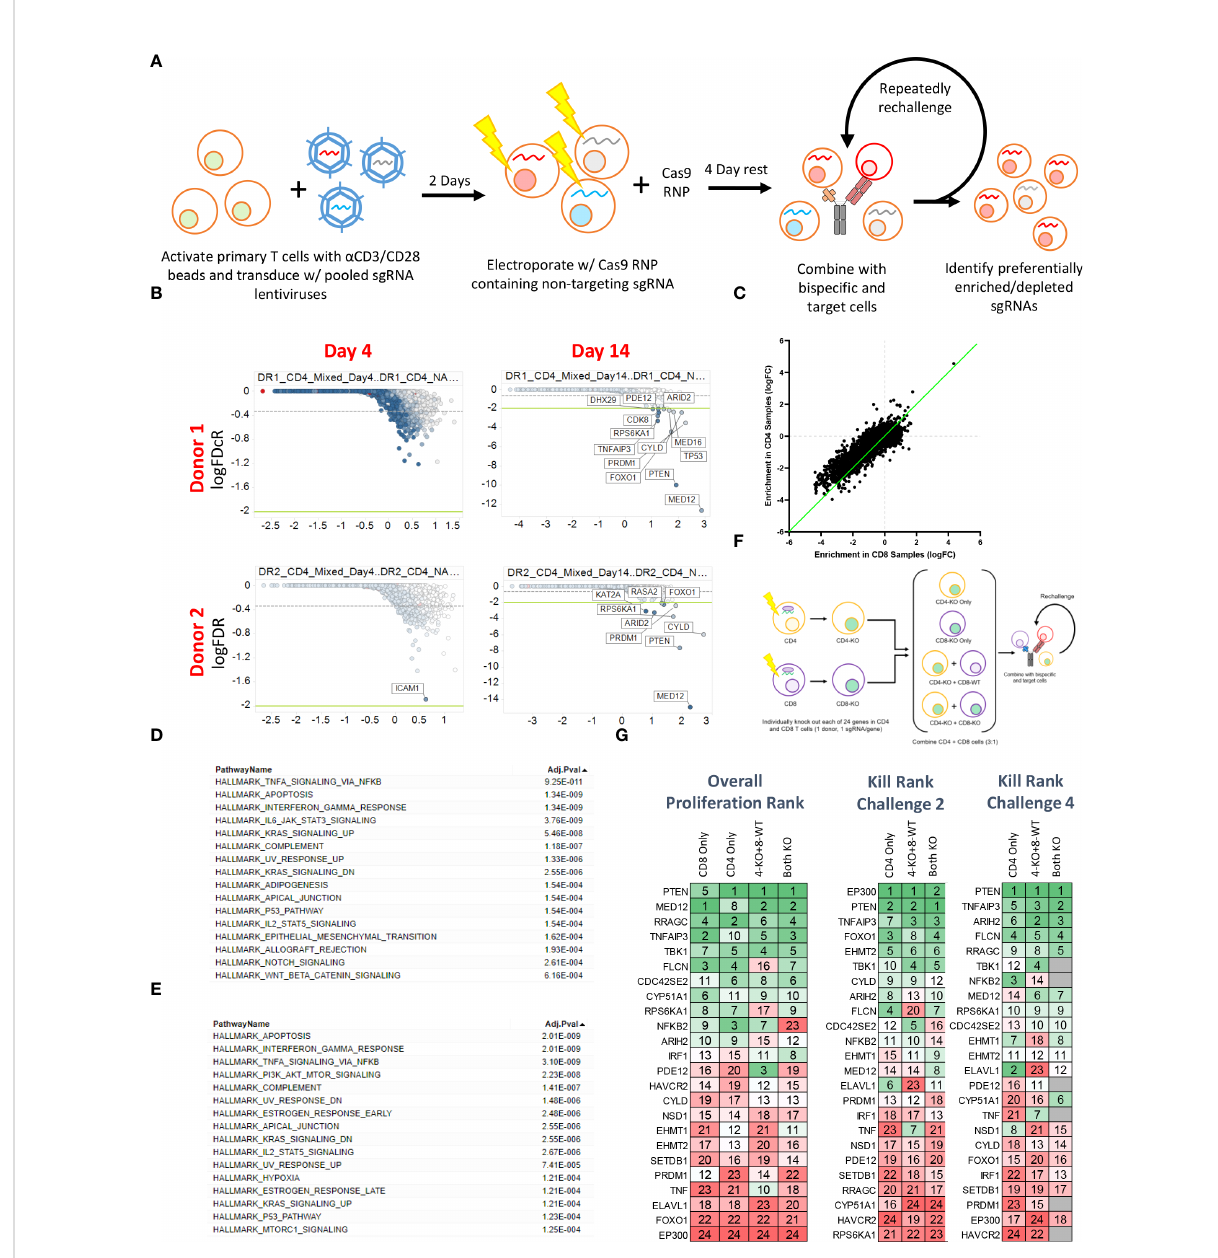
FIGURE 3 Pooled CRISPR screening enables the identi fi cation of genes regulating CD4 and CD8 T cell responses to BsAb-mediated activation. (A) Overview of the assay process. Brie fl y, T cells from two healthy donors were transduced with a lentiviral library encoding sgRNAs for approximately 1/3 rd of the human genome (10 sgRNAs/gene). Two days later, cells were electroporated with Cas9 complexed with a non- coding sgRNA. Cells were then repeatedly challenged with KMS11 target tumor cells every 3-4 days, with DNA being collected from T cells at each repeat challenge timepoint to assess sgRNA enrichment or depletion. (B) Representative plots of hit identi fi cation on days 4 and 14 of the challenge process in CD4+ T cells from each of the two screened donors. (C) Relative enrichment of different hits in CD4+ and CD8+ T cell samples, with each point corresponding to a single gene. The green line represents the y = x axis. D-E. Hallmark pathway analyses were used to assess pathway enrichment for the top 100 screen hits identi fi ed in (D) CD8+ T cells and (E) CD4+ T cells. (F) Screen validation strategy overview. (G) High-level validation result overview showing that the loss of different genes had differential impacts on long-term proliferation (after four challenges), killing after two challenges, and killing after four challenges. Genes were ranked from 1-24, with 1 indicating more killing or proliferation (as appropriate). Screening data were derived from two donors with two sets of CD4 and CD8 T cell samples per donor. Screening validation in (G) was performed in duplicate using T cells from a single